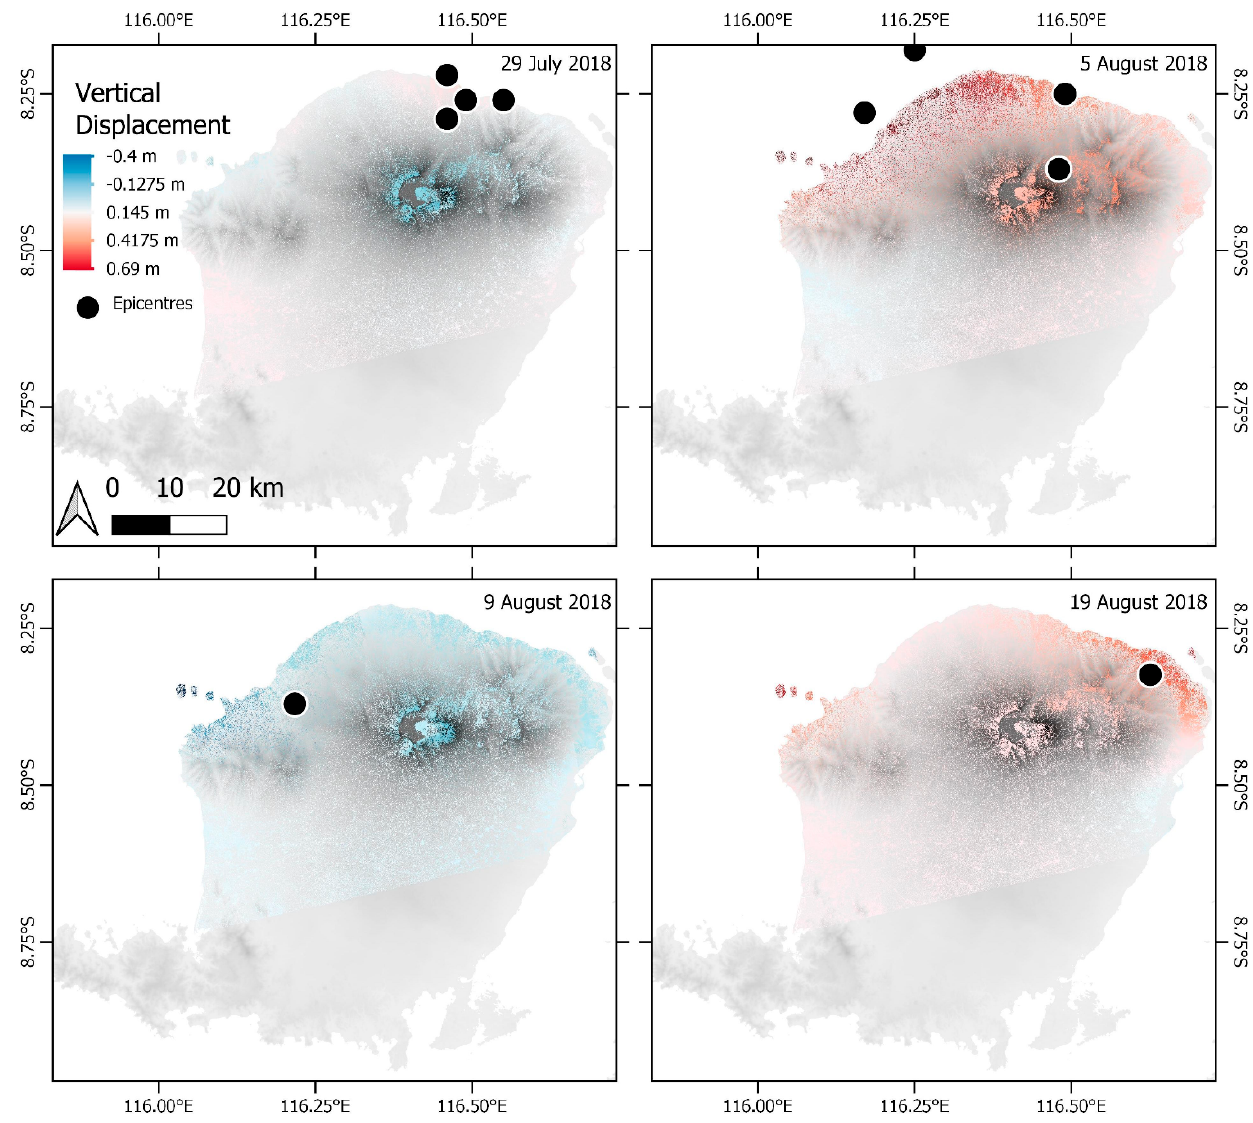
Figure 5. Spatial distribution of vertical displacement due to earthquakes on 29 July, 5 August, 9 August, and 19 August 2018.